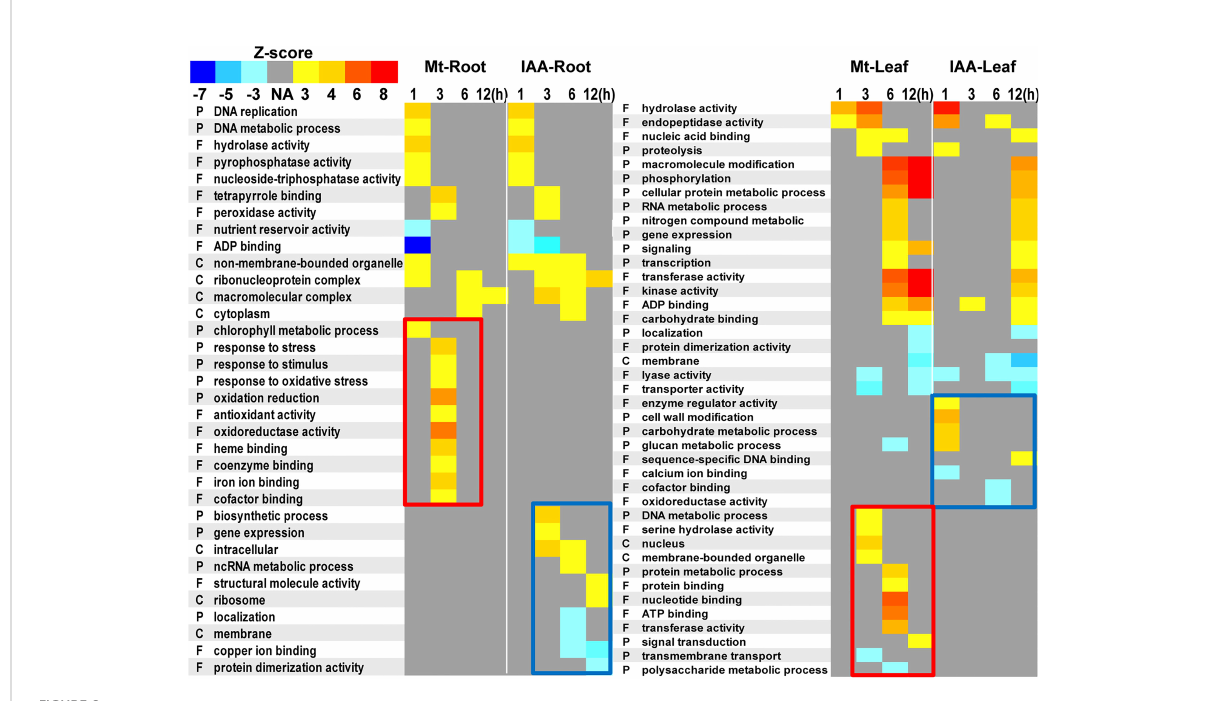
FIGURE 8 Gene ontology terms enriched in melatonin or auxin treated roots and leaves. DEGs of root or leaf samples were analyzed using agriGO. Statistical signi fi cance was evaluated using a Z-score method. P, biological processes; F, molecular functions; C, cellular components. Yellow to red colors indicate up-regulation of the GO terms, while cyan to blue colors indicate down-regulation of the GO terms. Red rectangles indicate speci fi c enrichment in melatonin treatment, while blue rectangles indicate speci fi c enrichment in IAA